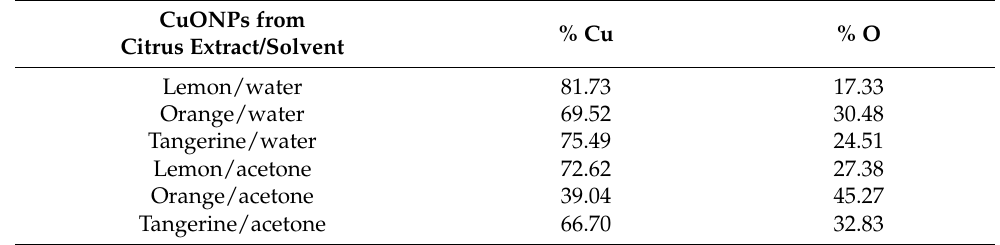
Figure 6. SEM images of CuONPs from citrus peel extracts using acetone as a solvent. ( a ) Lemon, ( b ) tangerine and ( c ) Orange. Table 1. EDS (energy-dispersive X-ray spectroscopy) data for CuONPs from citrus extracts of lemon, orange and tangerine using water and acetone